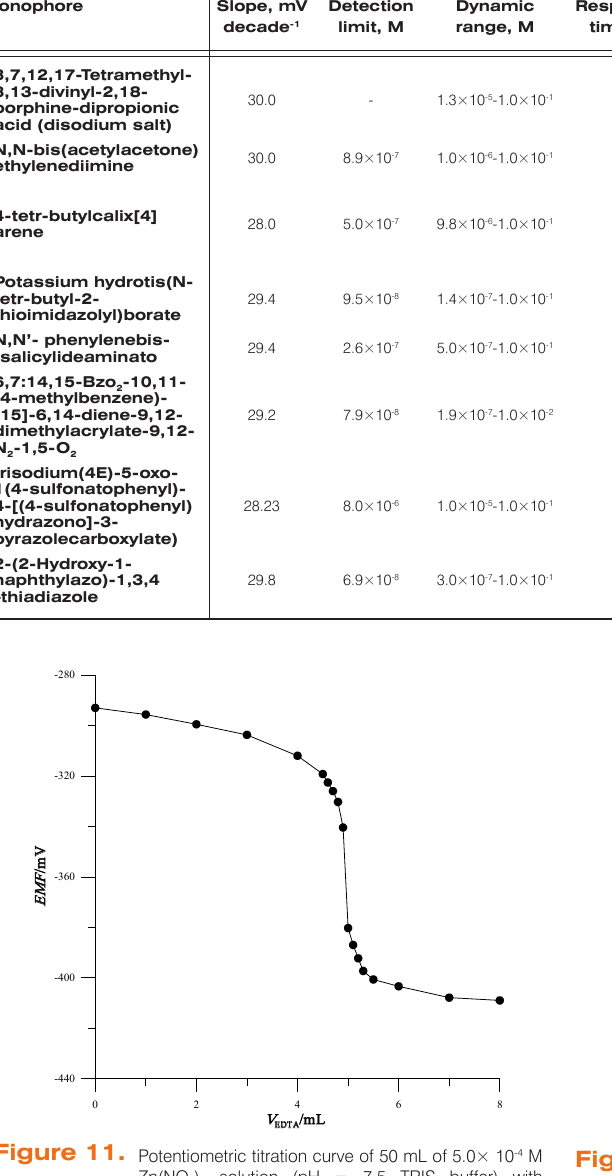
Figure 11. Potentiometric titration curve of 50 mL of 5.0× 10 -4 M Zn(NO ) solution (pH = 7.5 TRIS buffer) with 3 2 5.0× 10 -3 M EDTA solution using the proposed sensor as an indicator electrode.